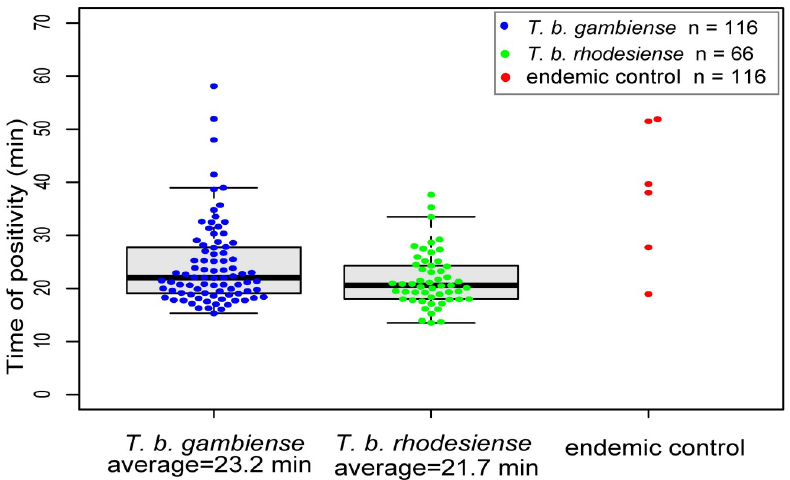
Fig 4. Time of positivity of CZC-LAMP HAT test in the HAT DNA samples. CZC-LAMP HAT was tested for 116 T . b . gambiense clinical samples, 66 T . b . rhodesiense samples, and 116 endemic control samples. The time of positivity was monitored by real-time PCR machine and is shown as blue, green, and red dots. A non-specific reaction was not observed at the 60-min time